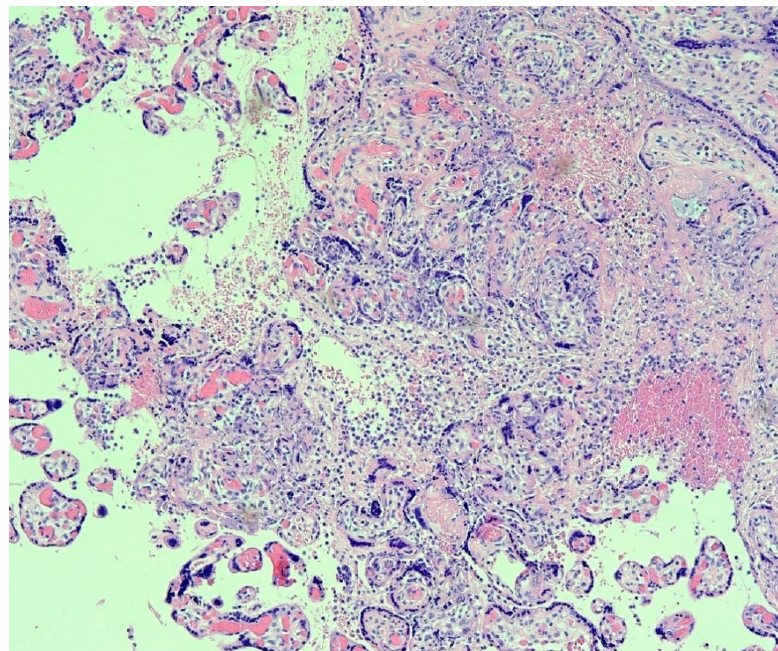
Figure 1. Placenta from a maternal-neonatal dyad with COVID-19. There is prominent chronic histiocytic intervillositis present in which the inflammatory cells in the intervillous space stained positive with the CD68 antibody. Necrosis of the syncytiotrophoblast layer on chorionic villi is visible even at this magnification. The findings, in this case, were indicative of intrauterine transplacental transmission of SARS-CoV-2. This placenta was described in [23]. Hematoxylin & eosin, ×10 magnification.